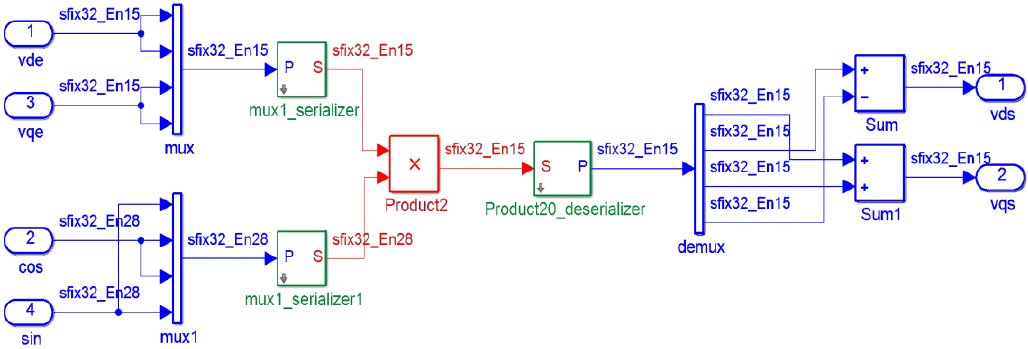
Figure 6. The block diagram for the PI controller. ( a ) The PI structure; ( b ) the integral control part.